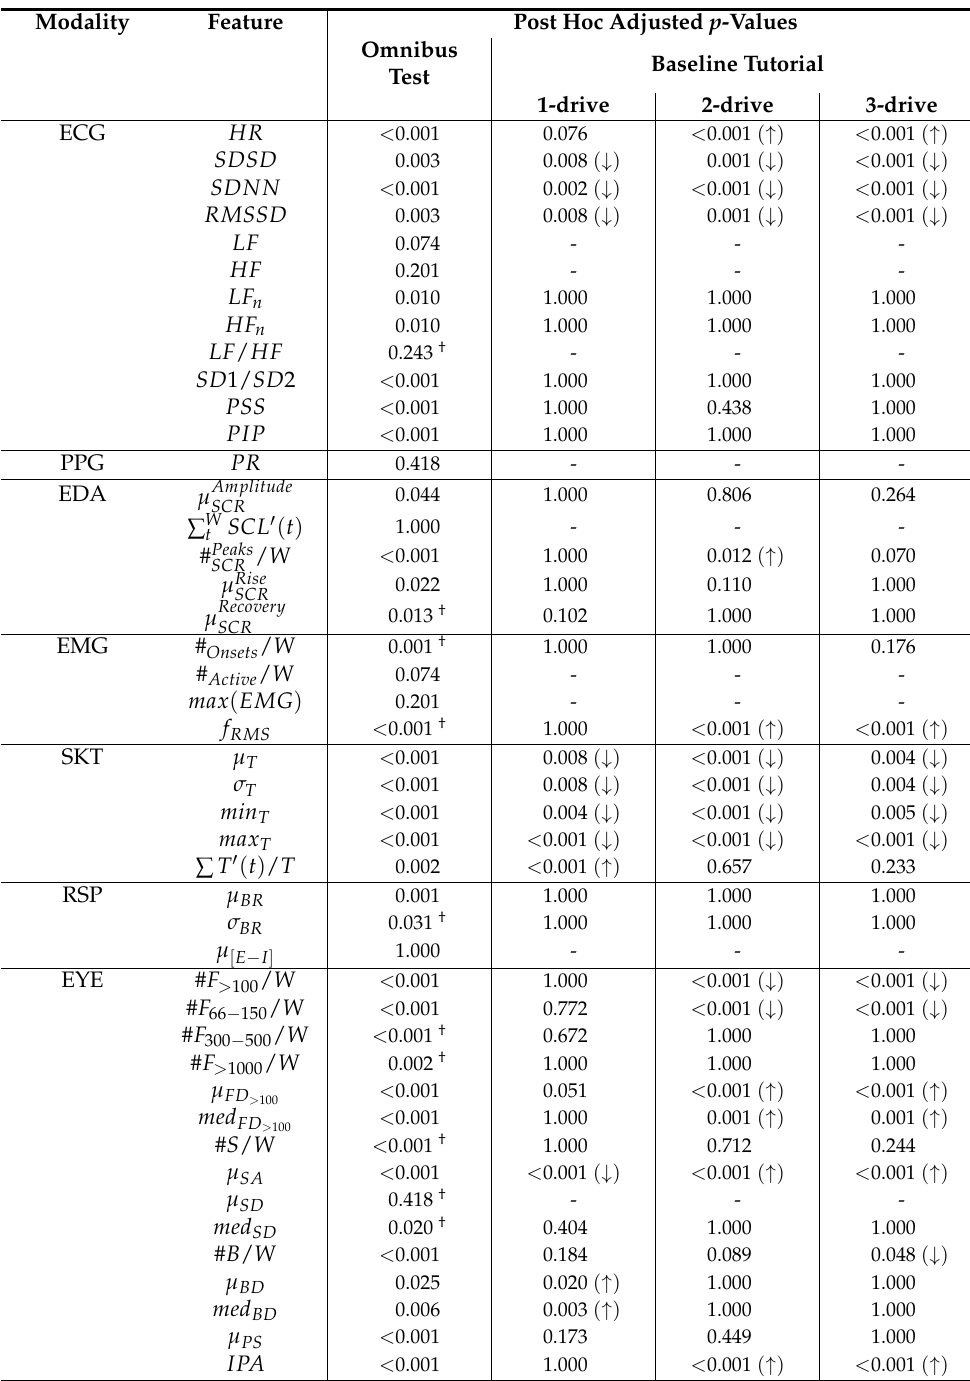
Table 5. Tabular view of statistical results for features computed during k -drive, indicating significant changes, for multiple modalities. All statistical tests are conducted according to Section 2.12. p -values are adjusted using Bonferroni-Holm. Post Hoc tests are performed for k driving tutorial